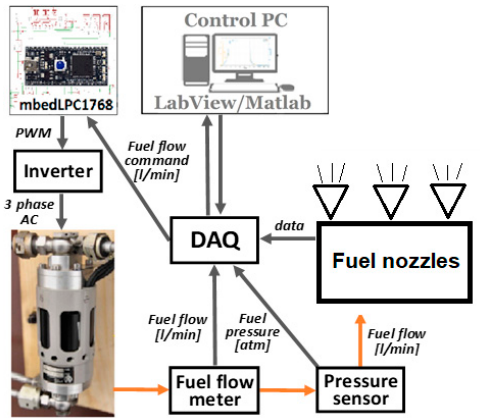
Figure 14. Fuzzy adaptive PID performance during a simulated fuel ‐ flow run.